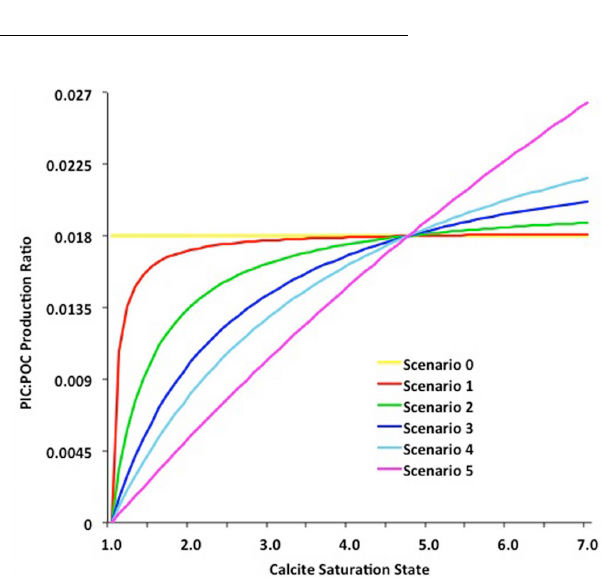
Fig. 1. CaCO 3 :particulate organic carbon production ratio depen- dence on calcite saturation